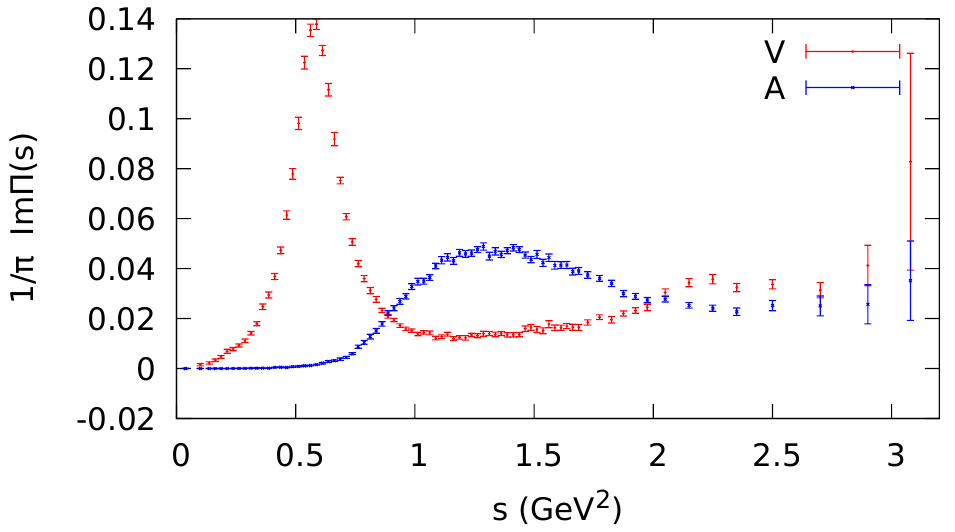
Figure 1 . ALEPH non-strange spectral functions 1